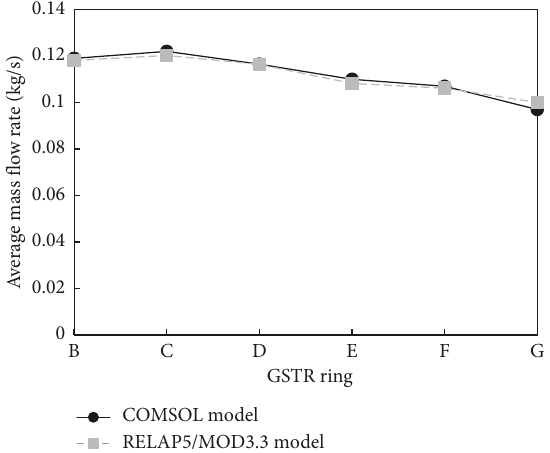
Figure 15: Average mass flow rate calculated by the single-subchannel models at each GSTR